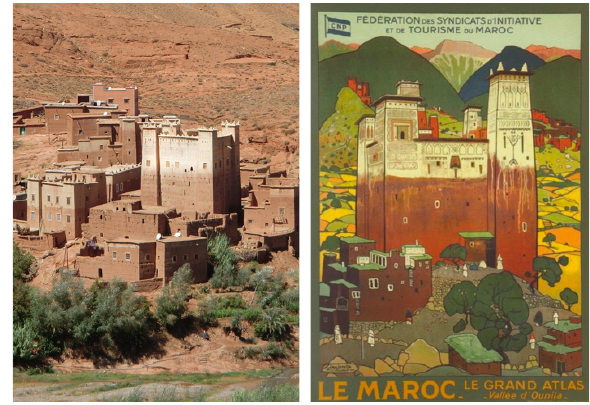
Figure 1. Left: Tighremt Aït Kho Haddou (L’hot). Right: Tourist poster of the “Fédération des syndicats d’initiative et de tourisme du Maroc”. Jacques Majorelle,